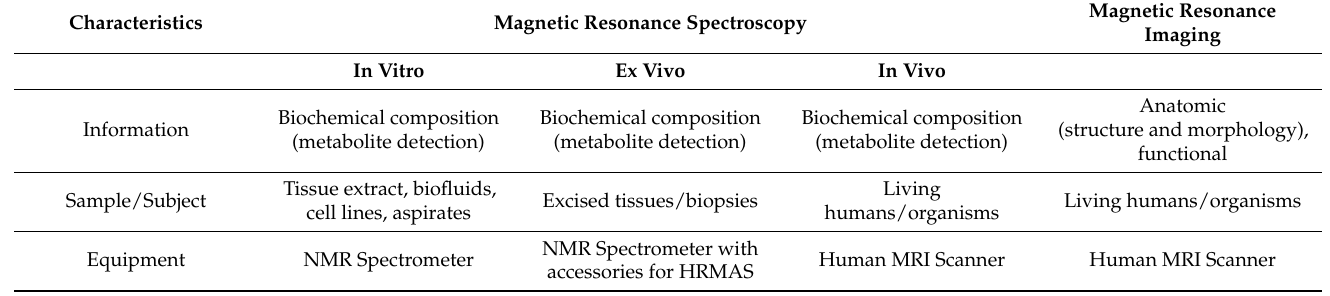
Table 1. Comparison of in vitro, ex vivo, and in vivo magnetic resonance spectroscopy (MRS) and MRI